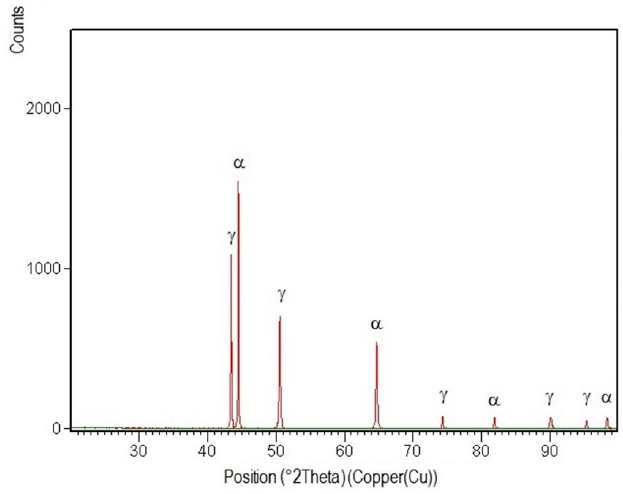
Figure 16. XRD pattern of the base metal.